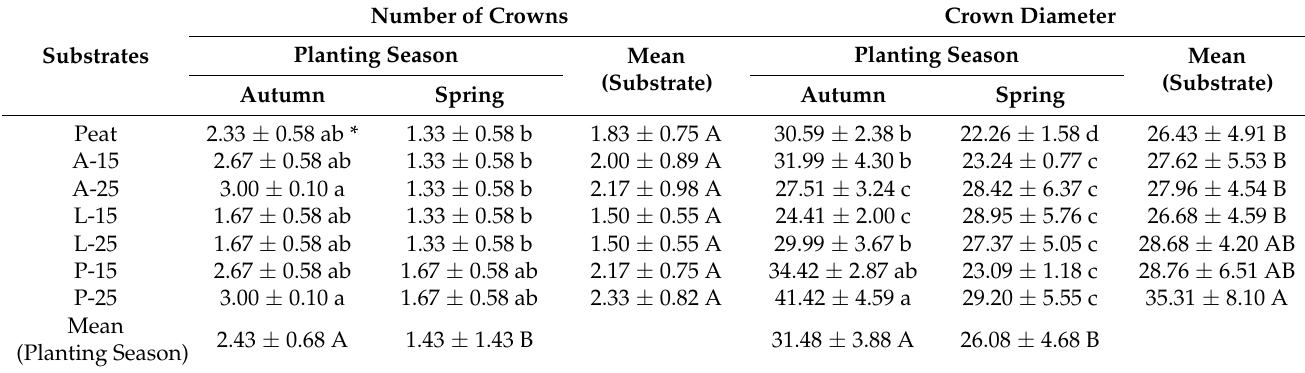
Table 9. Number of crowns and crown diameter (mm) as influenced by substrates and planting seasons. Number of Crowns Crown Diameter Planting Season Mean Planting Season Mean Substrates (Substrate) (Substrate) Autumn Spring Autumn